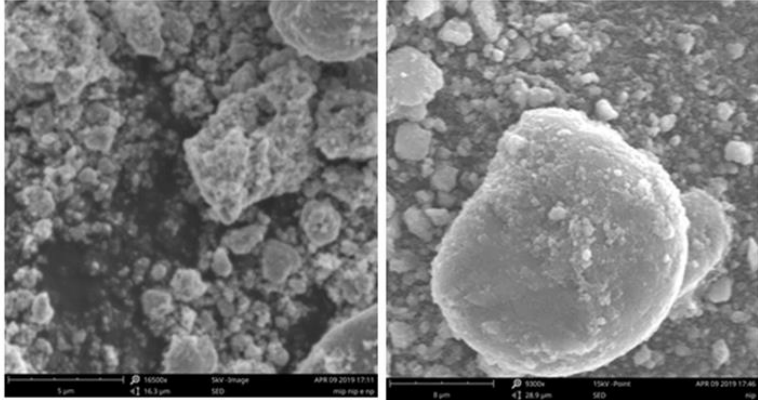
Figure 4. SEM images from DR-MIP (left) and DR-NIP (right).